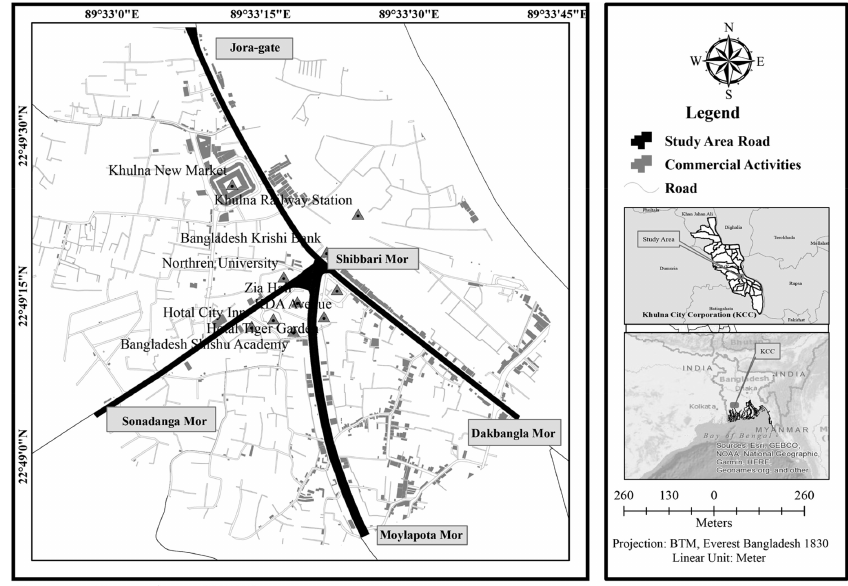
Figure 1. Mapofthestudyarea